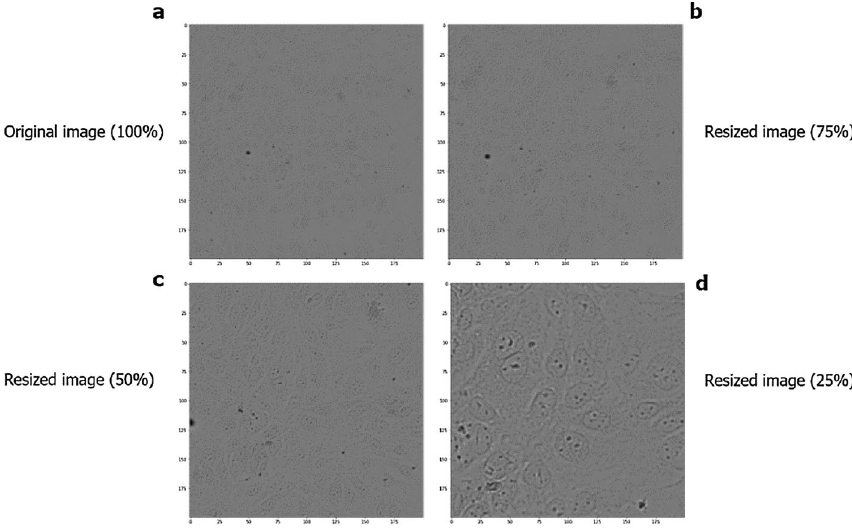
Figure 9. Microscopy images of the Huh7 cell line in different dimensions. ( a ) Original image. ( b ) Cropping 75% of the image. ( c ) Cropping 50% of the image. ( d ) Cropping 25% of the image.